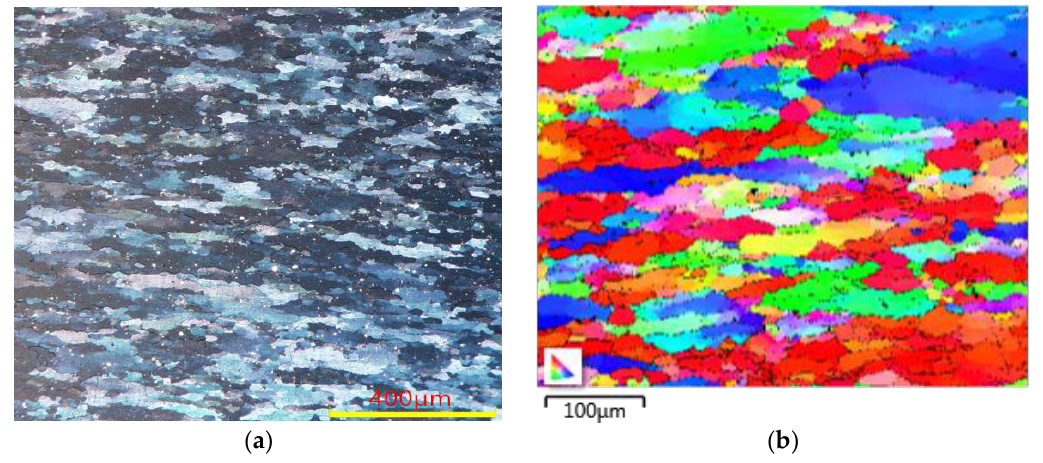
Figure 14. The deformed microstructures under the conditions of 500 °C and 0.1 s −1 using: ( a ) optical micrograph; and ( b ) electron backscattered diffraction (EBSD) mapping.